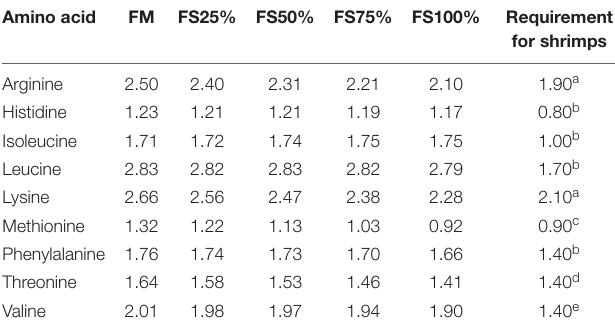
TABLE 3 | Essential amino acid profile (%) of experimental